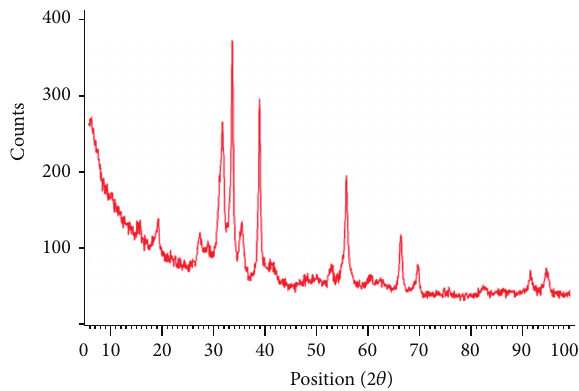
Figure 3: XRD pattern of BSA-ZnWO 4